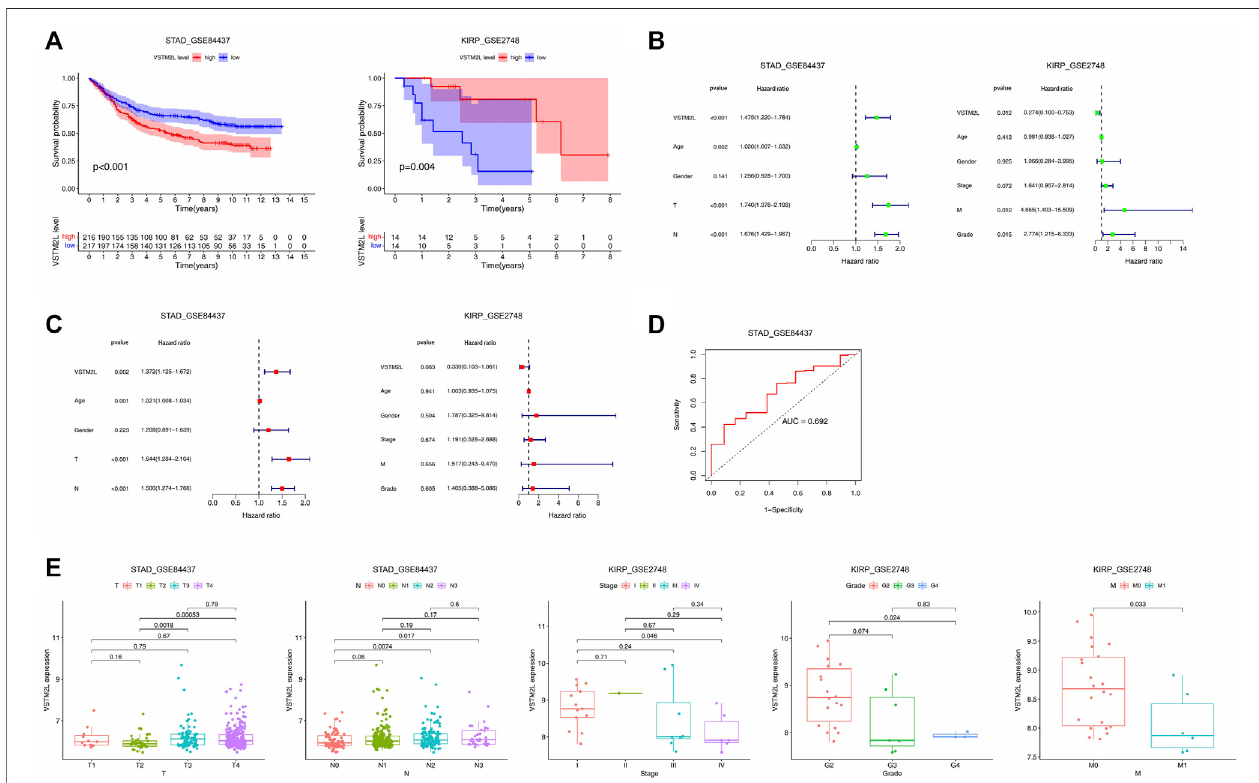
FIGURE 9 | Prognostic value of VSTM2L expression in STAD and KIRP. (A) OS of STAD patients in the GSE84437 dataset and of KIRP patients in the GSE2748 dataset. (B,C) Univariate (B) and multivariate (C) Cox regression analyses of VSTM2L expression level and clinical characteristics of STAD and KIRP patients. (D) Time receiver operating characteristic curve (ROC) analysis with area under the ROC curve (AUC) representing the prognostic performance of VSTM2L expression for OS in STAD patients. (E) Relationship between VSTM2L and tumor – node – metastasis stage in STAD and KIRP patients.